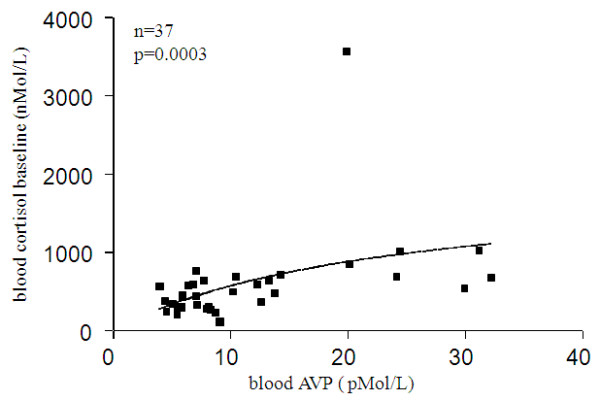
Correlation between blood AVP and cortisol baseline. The strongest association between these two parameters is shown in the non-septic ICU patient group: r = 0.5765 (95% CI: 0.2917 to 0.7674).